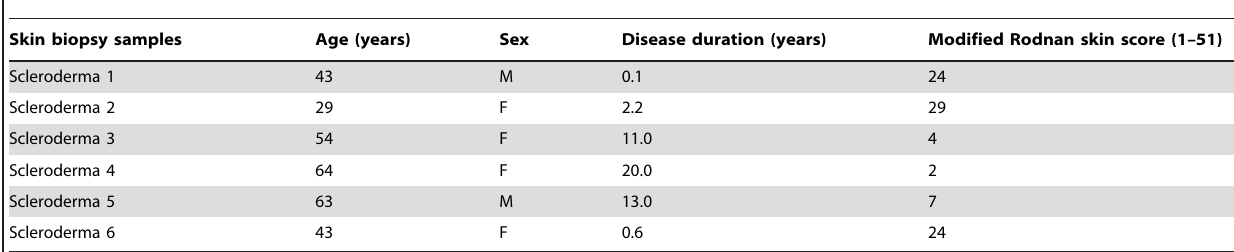
Table 2. Clinical characteristics of scleroderma patients studied.